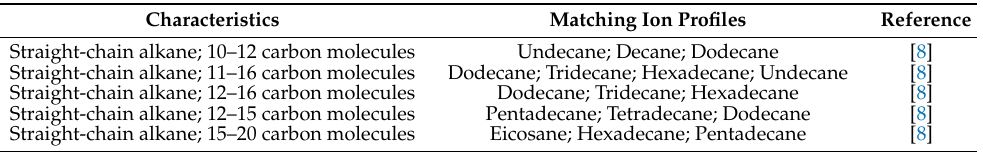
Table 3. Unidentified VOCs due to multiple comparable similarity scores; all these compounds are straight-chain